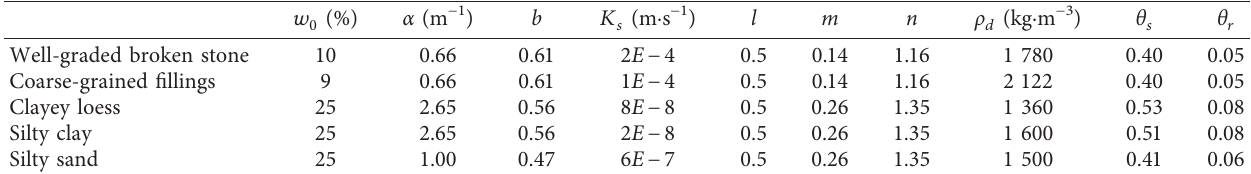
Table 2: Characteristic parameters of water for different